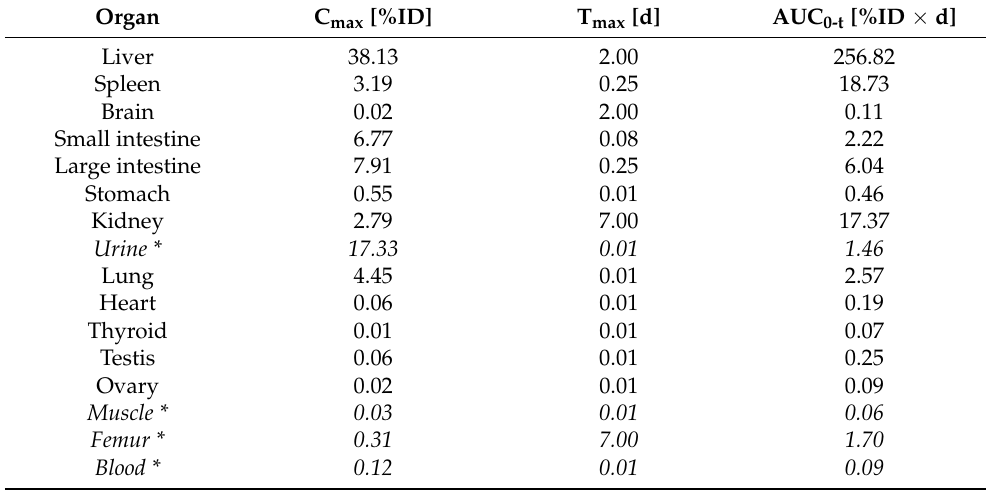
Table 4. Ex vivo pharmacokinetic parameters of 89 Zr-Exo following i.v. administration in various organs of SD